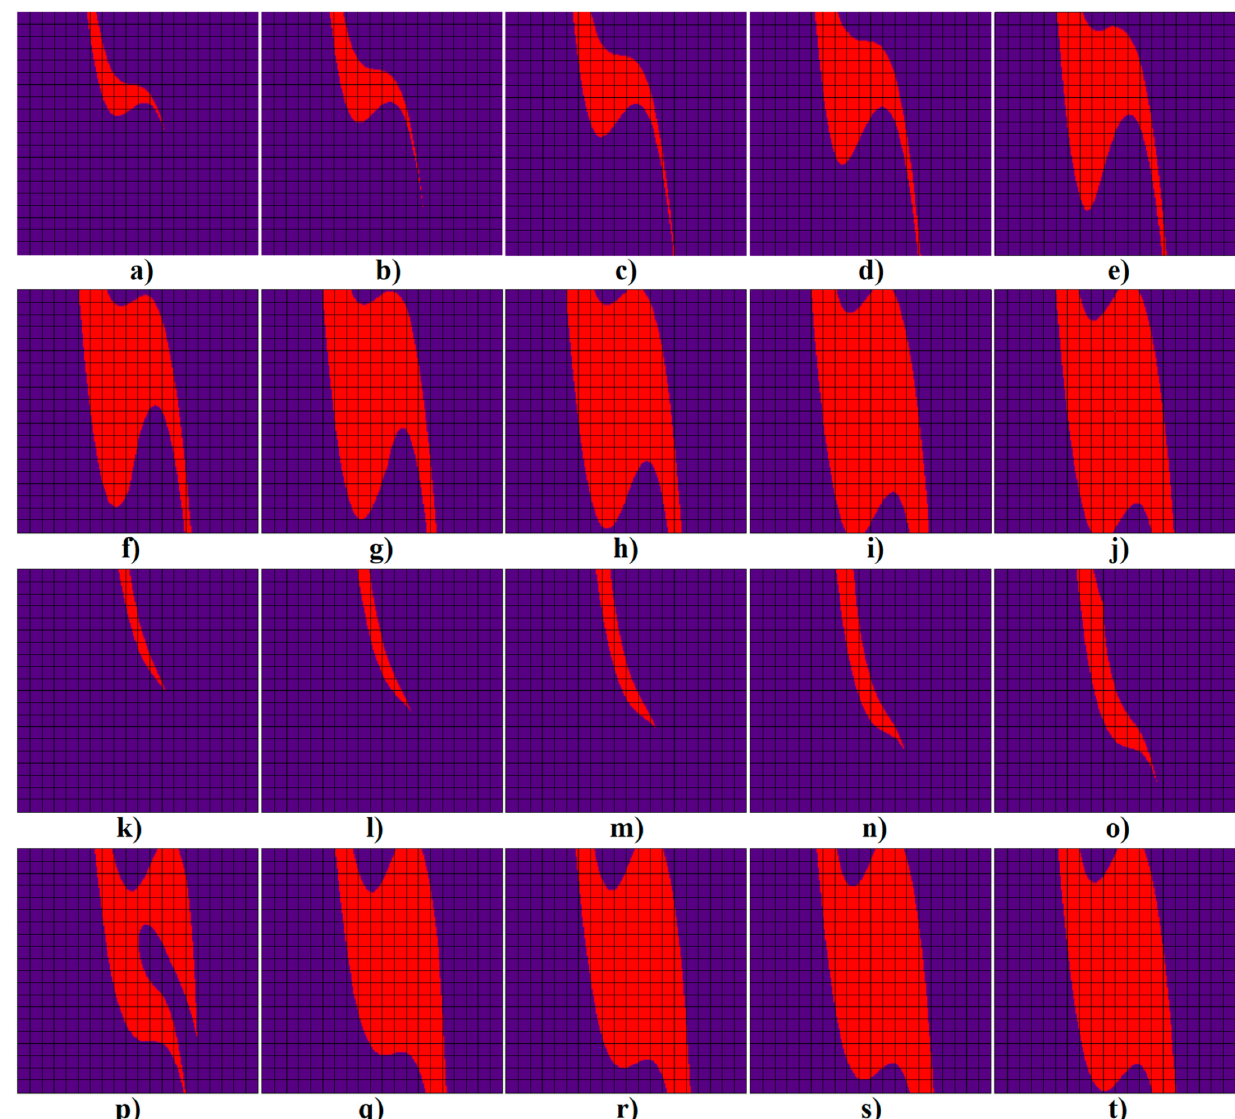
Figure 4. Basin of attraction for typical chaotic attractor visualized in v 1 vs. v 2 plane. State space slices are defined by i L = 0 A and the following planes: ( a ) v 3 = − 10 V, ( b ) v 3 = − 9 V, ( c ) v 3 = − 8 V, Lower gallery deals with state space slices given by zero voltage v 3 = 0 V and the following planes: ( r ) iL = − 3 A, ( s ) iL = − 2 A, and ( t ) iL = − 1